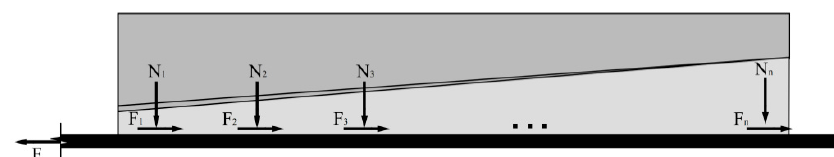
Figure 5. Internal force diagram of anchor.